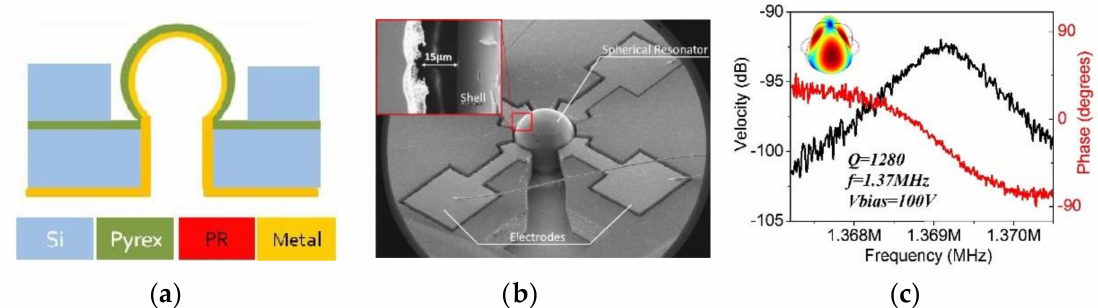
Figure 12. ( a ) Schematic showing design and different layers of final stage of coated Pyrex HRG with ALD coating, ( b ) and fabricated HRG, ( c ) Frequency and phase response of HRG in n = 2 mode of vibration (Giner et al. [95]) © 2022 IEEE. Reprinted, with permission from IEEE from J. Giner, J. M. Gray, J. Gertsch, V. M. Bright and A. M. Shkel, “Design, fabrication, and characterization of